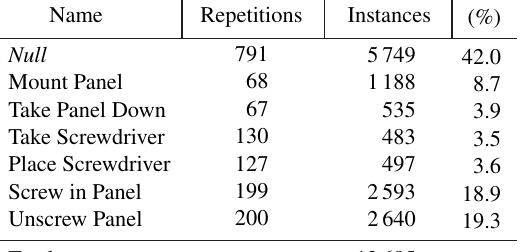
Mount Place Screw- Worker takes the cover panel and loosely mounts it.